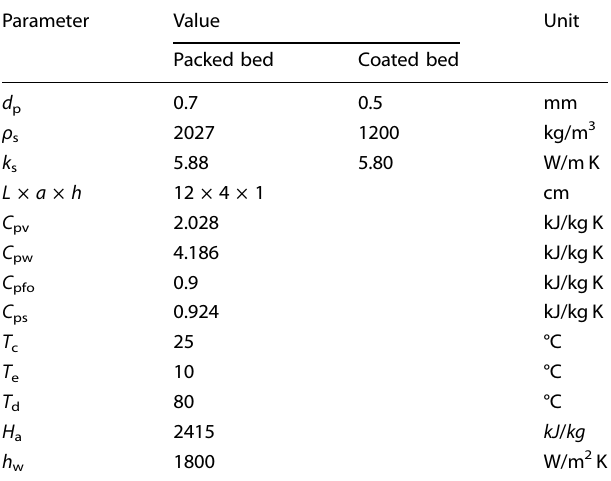
Table 1. Main parameters applied in the present